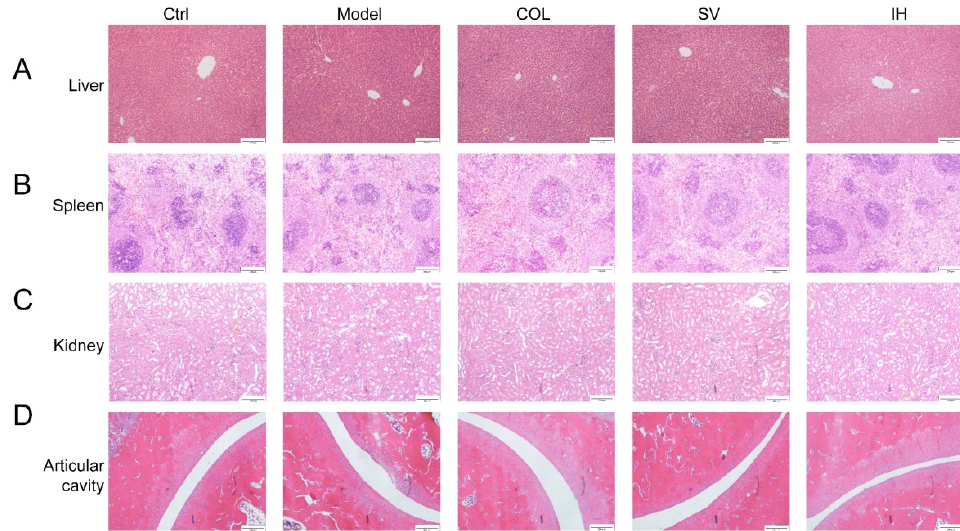
Figure 3. SV and IH relieve the swelling ration of ankle joints in MSU-induced acute gouty arthri- tis in rats. ( A ) Schematic diagram of the experimental schedule performed in rats with gouty ar- thritis. ( B ) SV and IH suppressed the swelling ratio of ankle joints in rats with acute gouty arthri- tis. Data are shown as means ± SD ( n = 6 rats/group). # p < 0. 05, ## p < 0. 01, ### p < 0. 001 vs. Ctrl